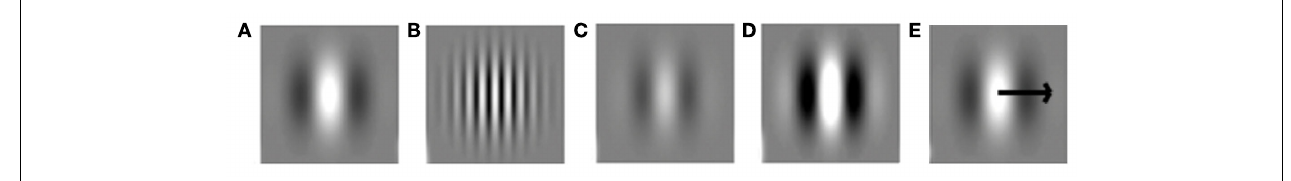
FIGURE 1 |Visual grating stimuli often used for the investigation of processing of stimulus characteristics. (A) Low spatial frequency. (B) High spatial frequency. (C) Low luminance contrast. (D) High luminance contrast. (E)